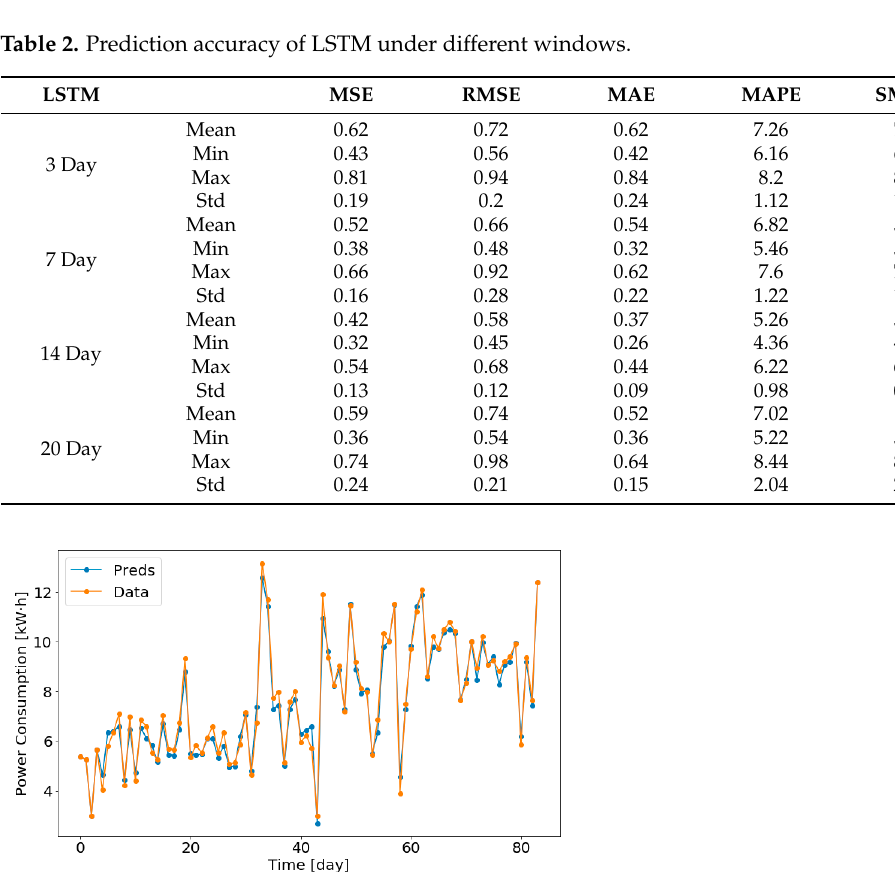
Figure 8. Prediction effect of GRU under 14-day sliding window.